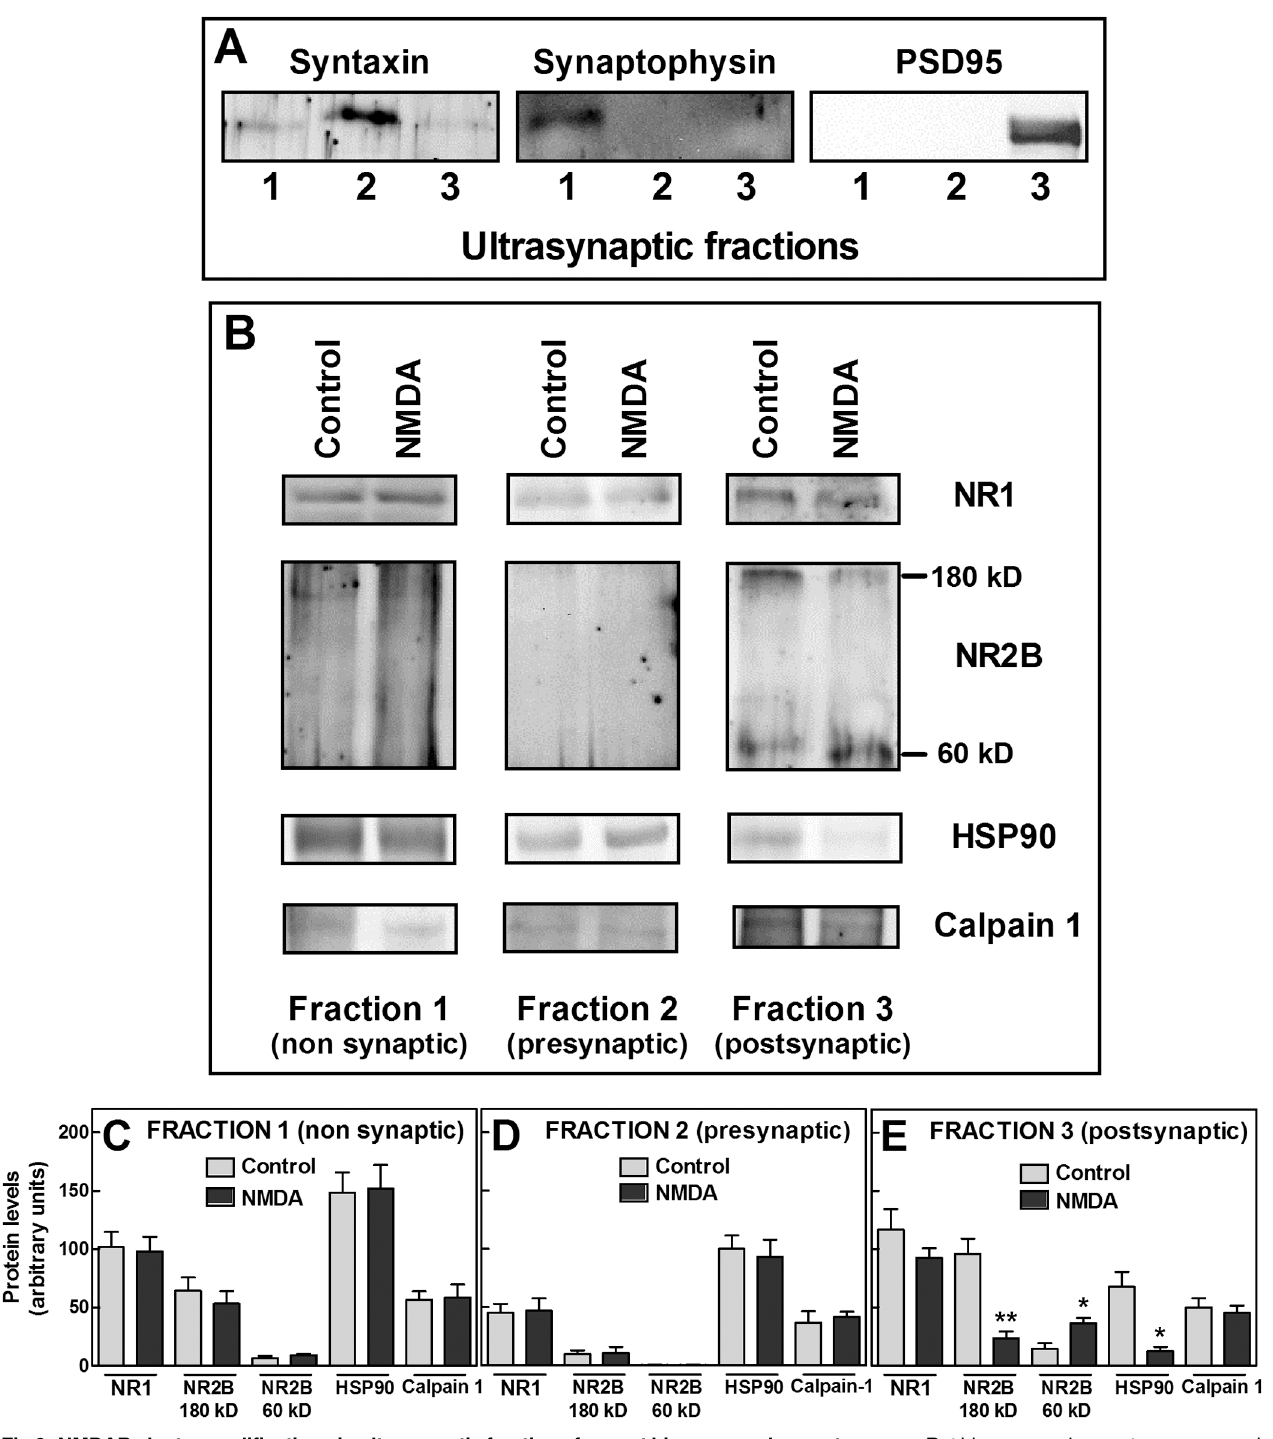
Fig 8. NMDAR cluster modifications in ultrasynaptic fractions from rat hippocampal synaptosomes. Rat hippocampal synaptosomes were incubated at 37°C for 12 min with (NMDA) or without (Control) 100 μ M NMDA in HEPES buffer containing 1 μ M glycine and 1 mM CaCl 2 . Synaptosomes were then lysed and ultrasynaptic fractionation was carried out as described in Methods. (A) Aliquots (20 μ g according to Lowry assay) of each fraction were submitted to 10% SDS-PAGE followed by immunoblot for the indicated markers. Lane 1, non synaptic fraction; lane 2, presynaptic fraction; lane 3, postsynaptic fraction. A representative immunoblot (of three) is shown. (B) Immunoprecipitation was carried out on each fraction by using anti-NR1 antibody. The immunoprecipitated material was analyzed by immunoblotting to detect the indicated proteins. Each immunoblot is representative of three different experiments.(C, D, and E) The protein bands detected in (B) were quantified as described in Methods. Each value represents the arithmetical mean ± SEM of three different experiments. ** p < 0.01 and * p < 0.05 vs control, according to t -test.